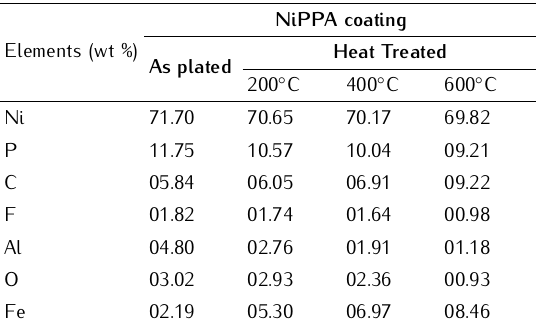
Table 2. Composition (wt %) of electroless NiPPA coatings of as plaed and at different temperatures